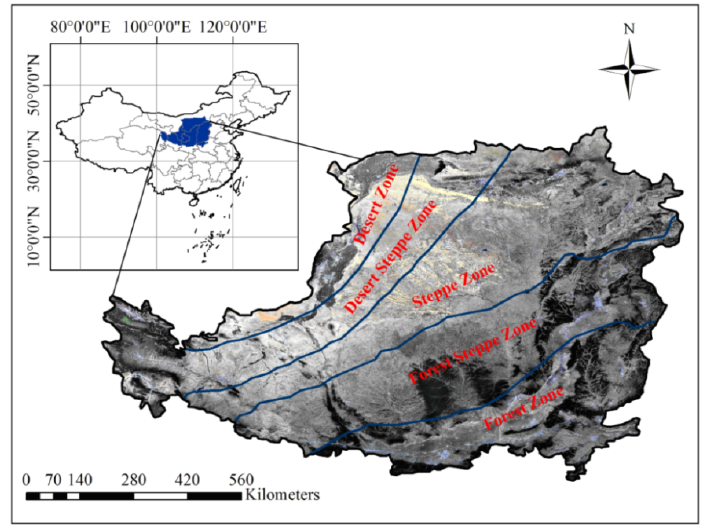
Figure 1. Location of Loess Plateau in Northwest China with its Google Earth image and its potential vegetation zones: forest, forest steppe, steppe, desert steppe, and desert zones